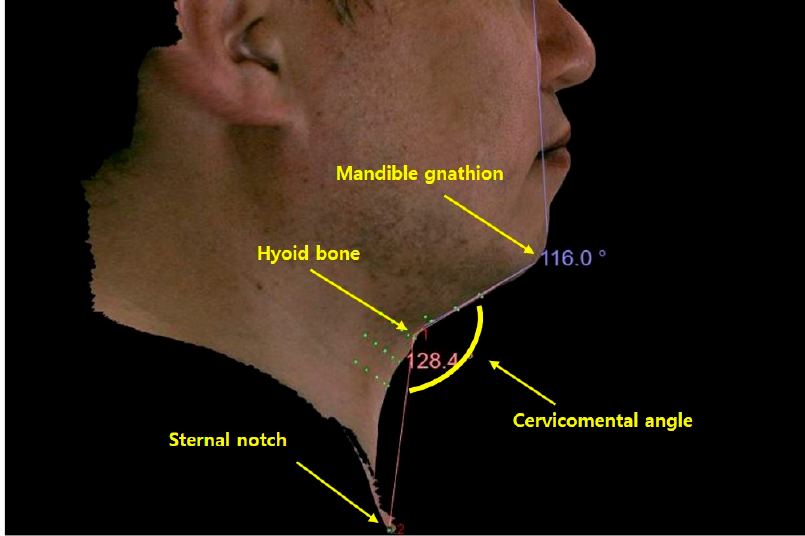
Figure 3. Measuring cervicomental angle using three-dimensional analysis.